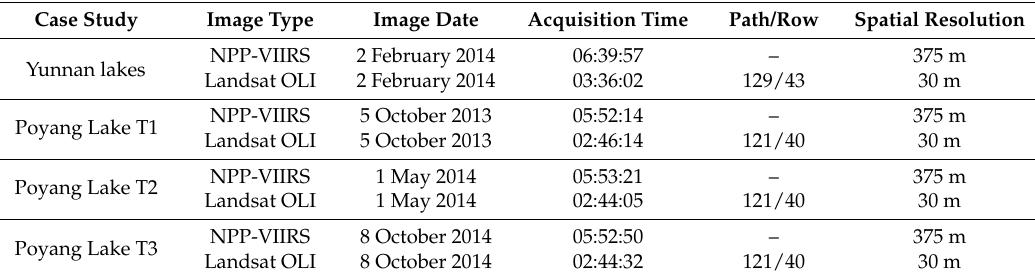
Table 1. Selected case studies and remotely sensed images involved.